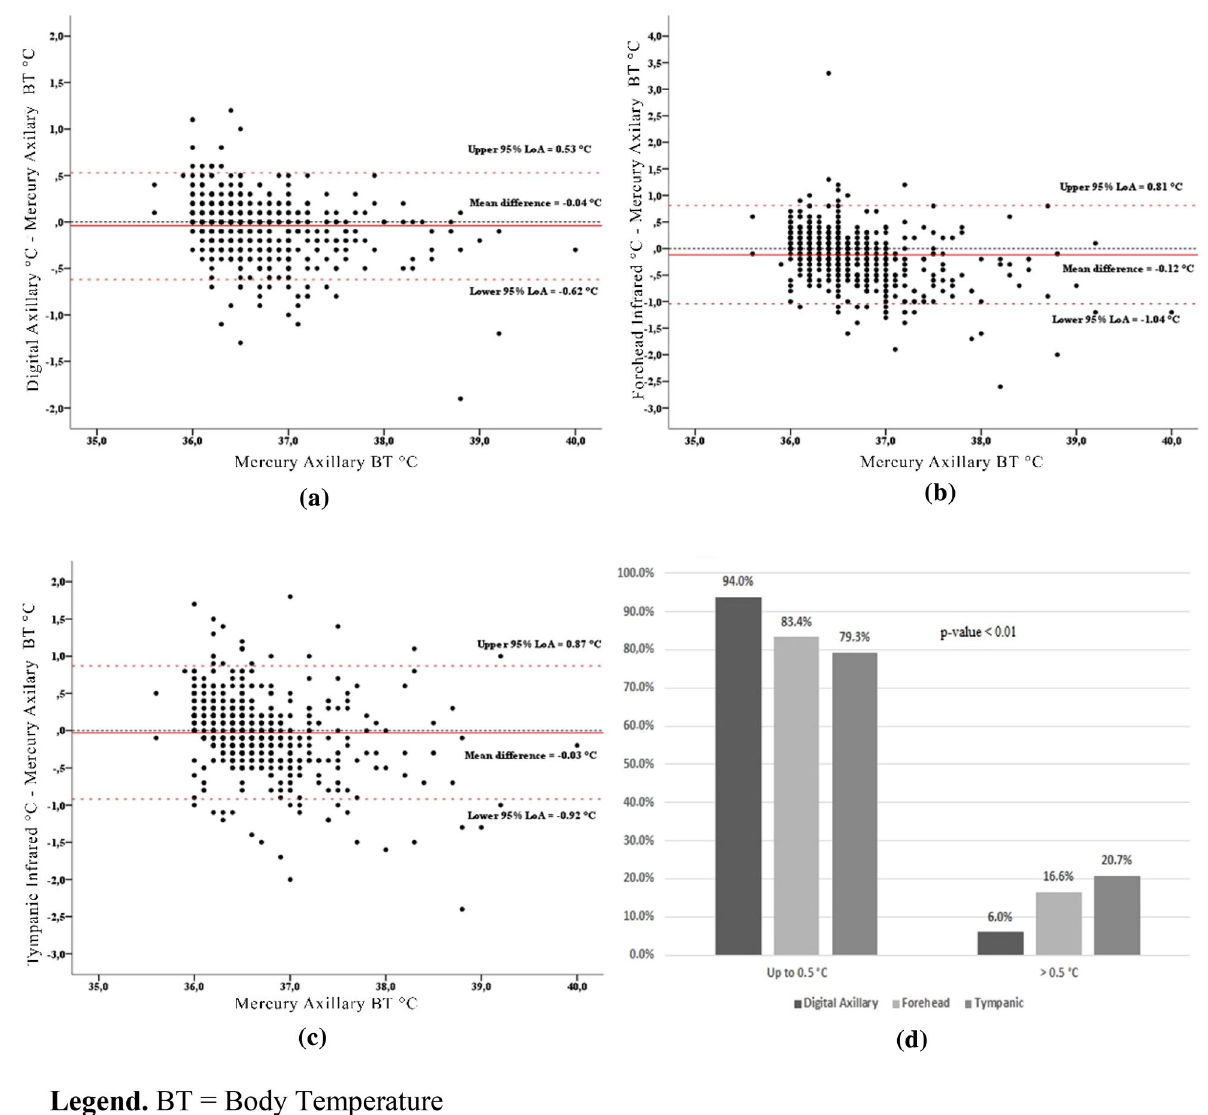
Figure 3. Paired comparisons between the axillary mercury thermometer and the other devices. BT Body Temperature; ( a ) Digital Axillary vs. Mercury Axillary; ( b ) Forehead Infrared vs. Mercury Axillary; ( c ) Tympanic Infrared vs. Mercury Axillary; ( d ) Percentage of mean differences between Mercury and other thermometers falling under 0.5